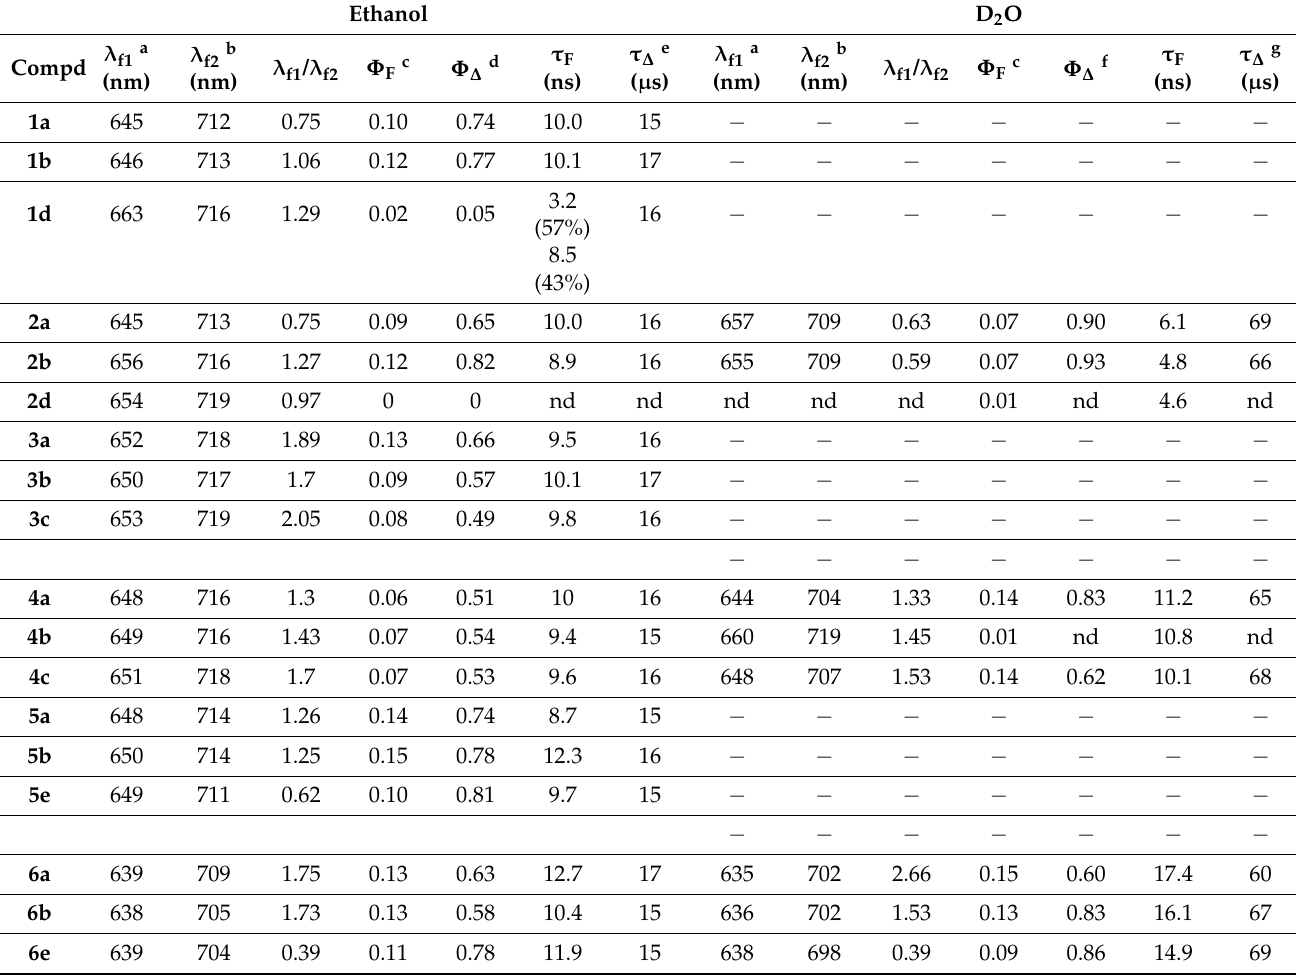
Table 4. Photophysical properties of the porphyrins in ethanol ( λ exc = 414 nm). Ethanol D 2